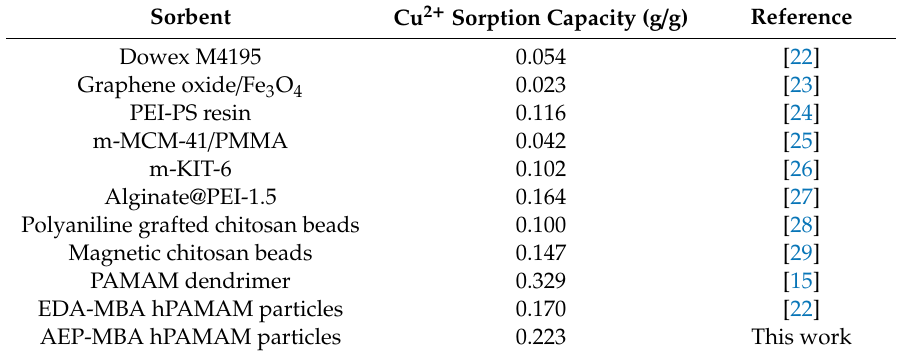
Table 1. Copper (II) ion sorption capacities of various sorbents. hPAMAM: Hyperbranched poly(amidoamine); EDA: Ethylenediamine. Sorbent Cu 2 + Sorption Capacity (g / g)